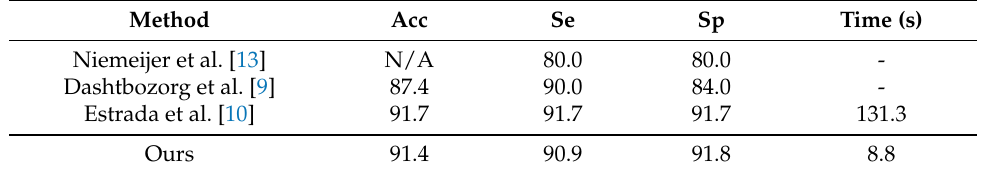
Table 2. Performances of different AV classification methods on the CT-DRIVE dataset. Accuracy (Acc), sensitivity (Se), specificity (Sp), and average per-image computation time are presented. Method Acc